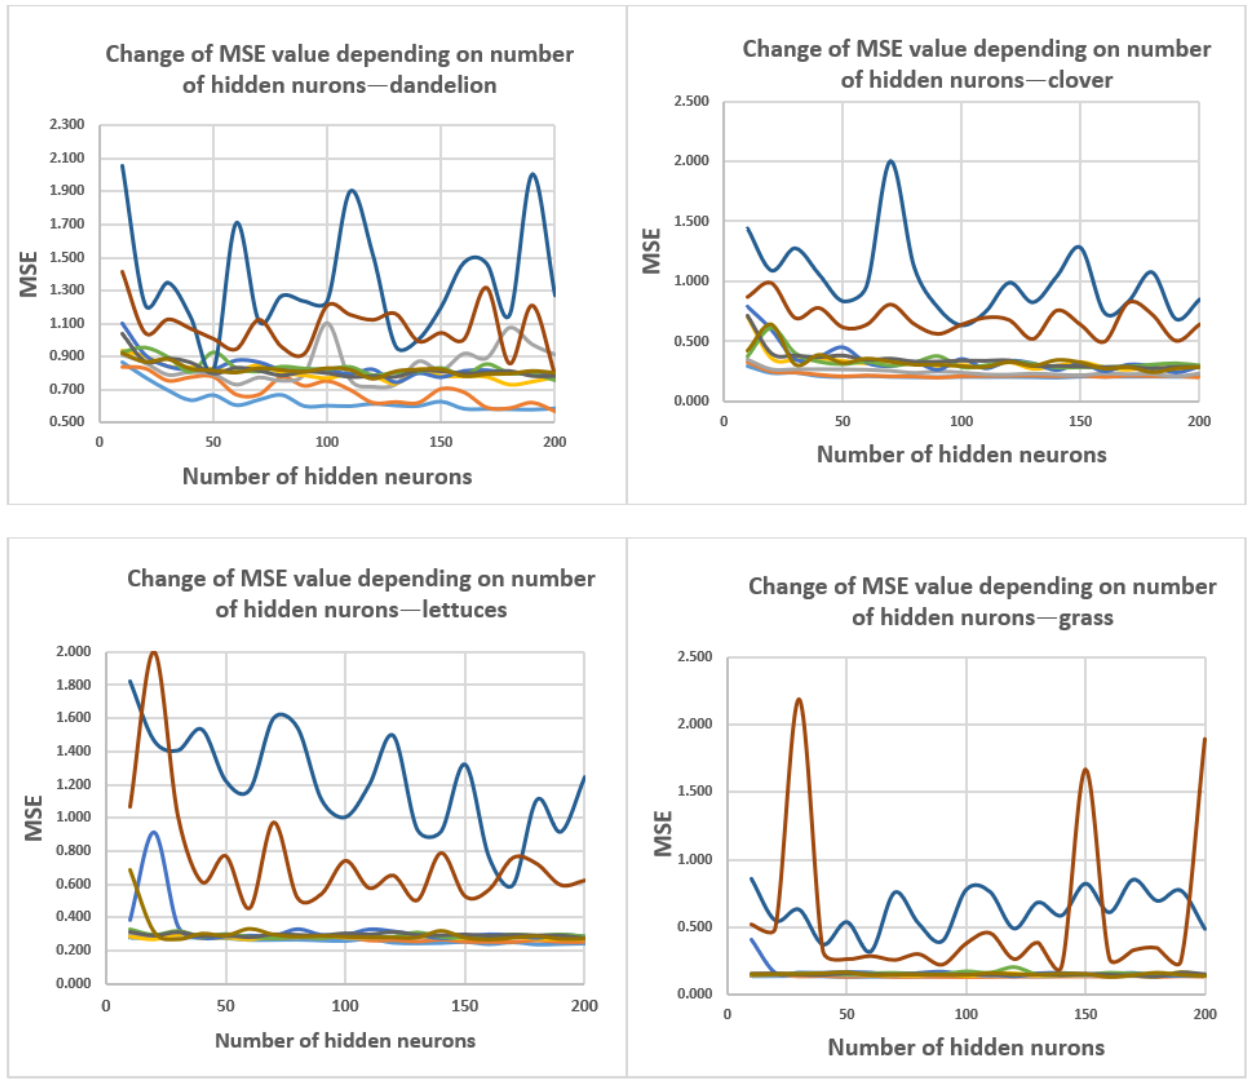
Figure 12. Comparison of artificial neural network learning methods for the following objects: leaf of common dandelion, cloverleaf, lettuce leaf, and blade of grass.